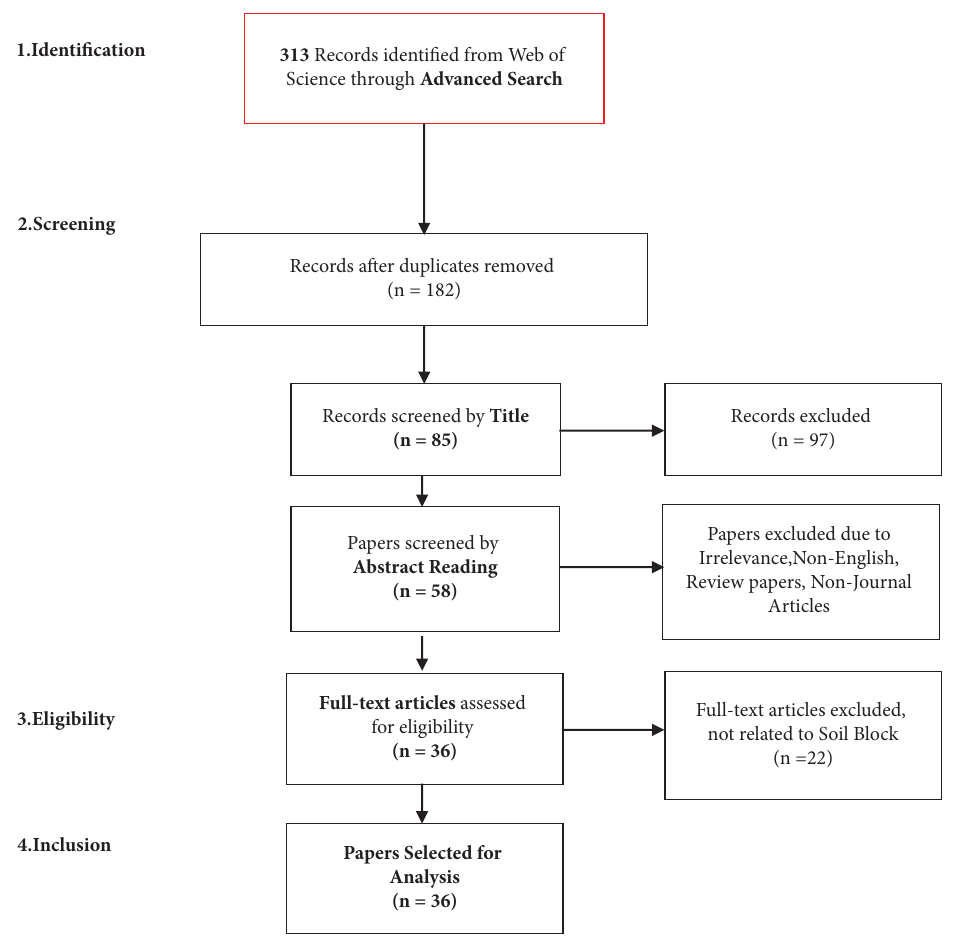
Figure 1: Different phases of the review to select the 36 papers for final analysis as per PRISMA Table 1: Inclusion and exclusion criteria used for the selection of relevant papers.